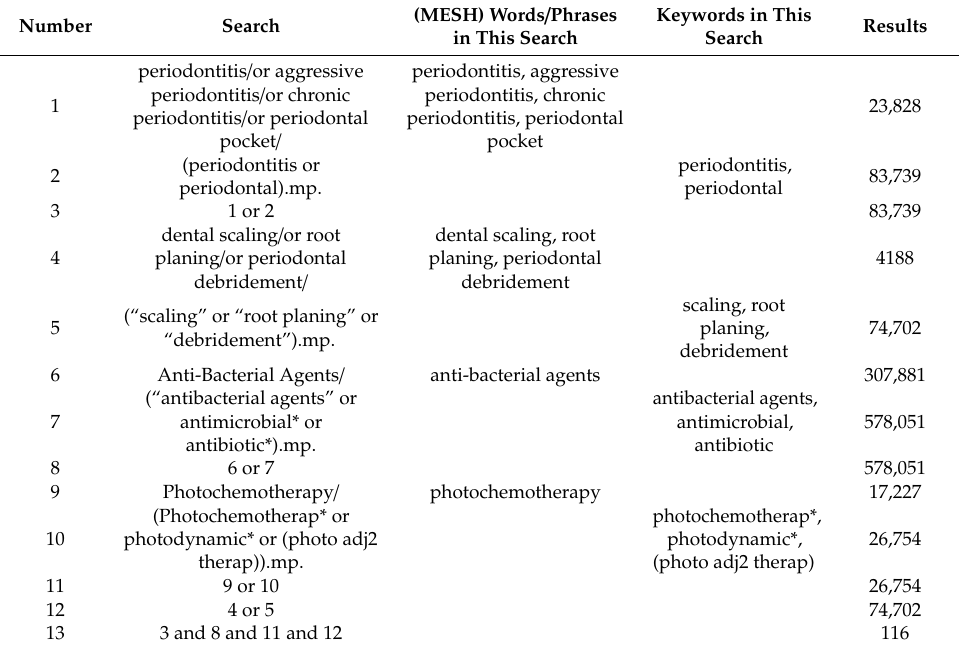
Table A1. Search strategy used for MEDLINE (Via OVID